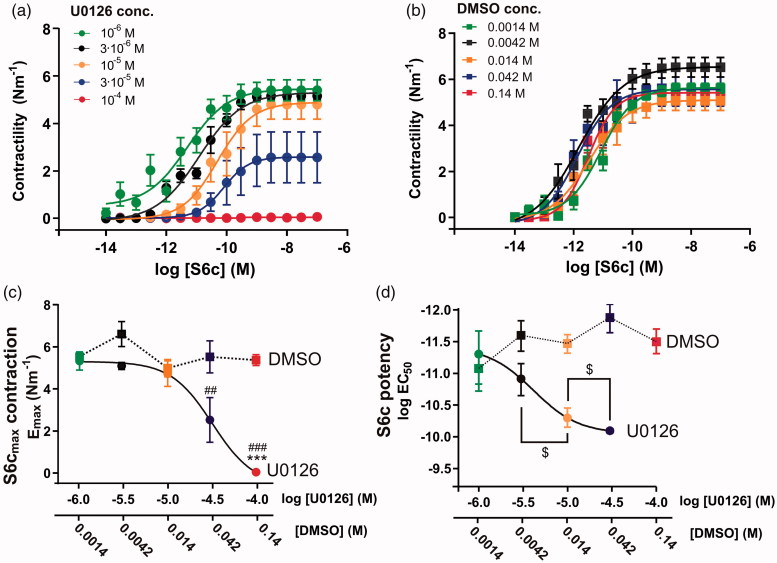
Concentration-dependence of U0126 (and DMSO) on S6c contractility after 48 h organ culture. Basilar arteries were incubated with different concentrations of (a) U0126 and corresponding concentrations of (b) DMSO. (a,b) Concentration-response curves to S6c show varying EC50 and Emax values. (c,d) Correlation between the concentrations of either U0126 or corresponding concentrations of DMSO (on the double x-axis) of Emax (c) or log EC50 (d) from the concentration-response curves with S6c (a,b). Values are listed in the Table S1, one-way ANOVA with Holm-Sidak post-test (##p < .01 and ###p < .001) or multiple t-tests with Holm-Sidak correction for multiple testing (***p < .001), $=non-overlapping 95% confidence intervals. Data are expressed as mean ± SEM, n = 4–15.